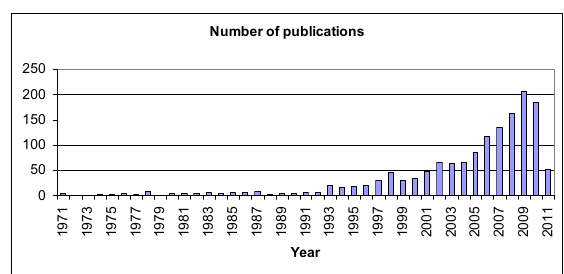
Figure 3. The number of DTA-related publications over